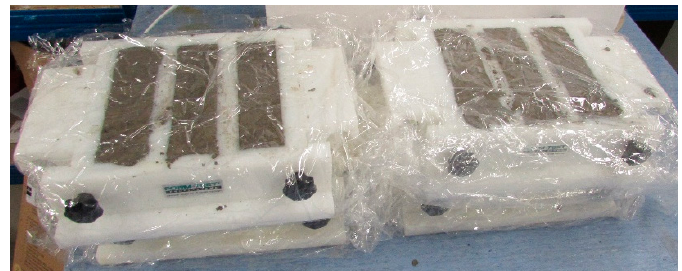
Figure 5. Test specimens in Hakorit molds (PE-foil wrapping is used).